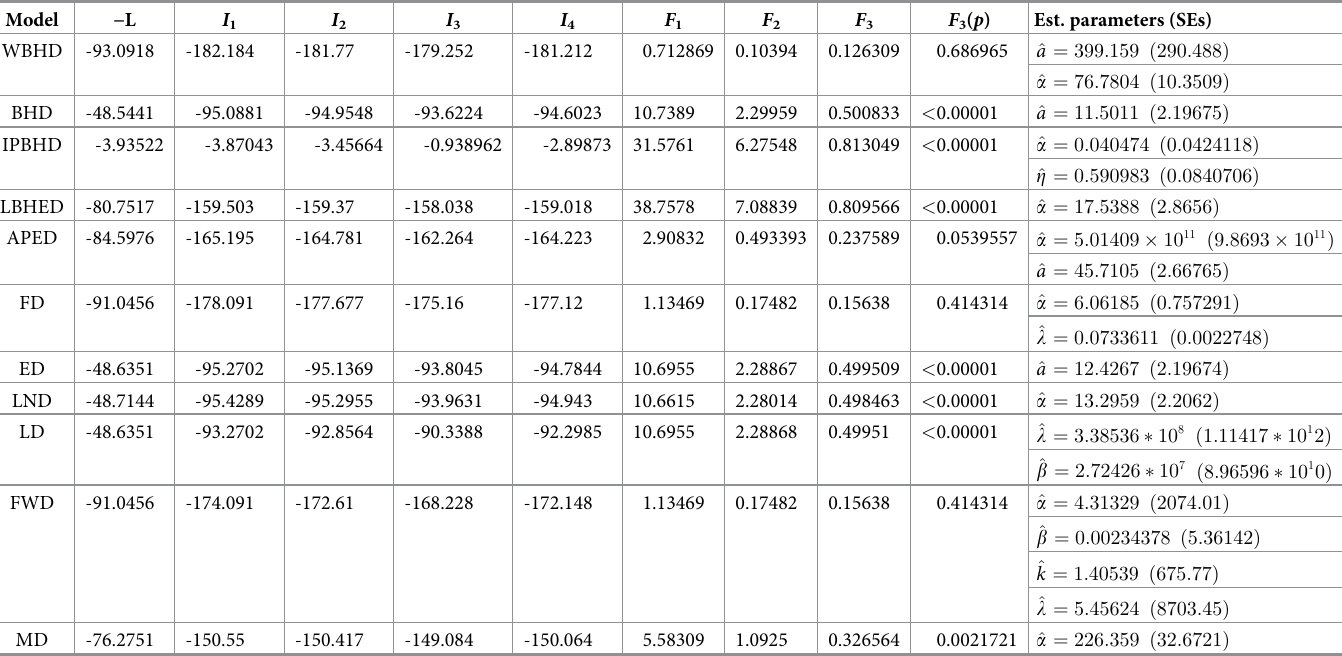
Table 9. Numerical values for analyzing the first COVID-19 real data set. Model −